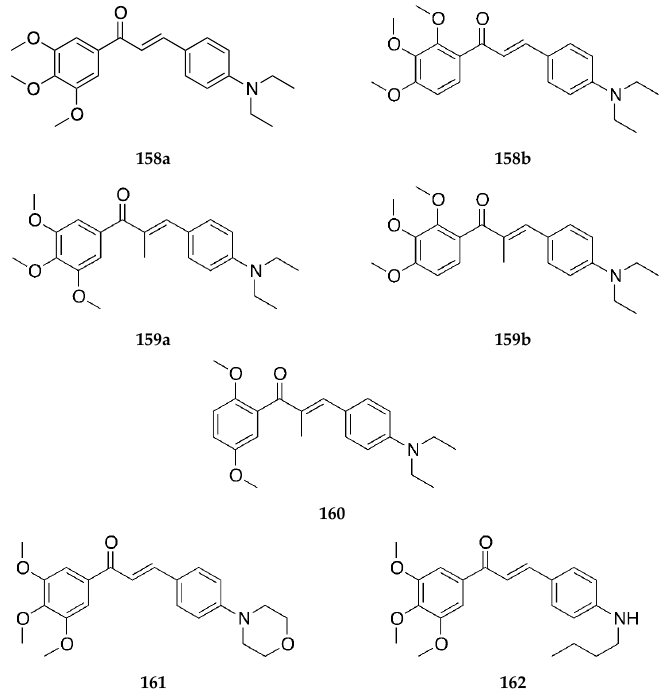
Figure 57. Chemical structure of other alkylated 4′-aminochalcone derivatives with methoxy substitutions on ring A. All compounds 144a , 144c , 143 , and 146 – 162 (Figures 55–57) were tested for their antimitotic activity via an in vitro assay system using HeLa cells. The cell cycle for this asynchronous line is 24 h, and mitosis requires 1 h. Colchicine was used as the reference drug, which stops mitosis at a concentration of 0.05 µg/mL. The activity for these chalcones was reported as the equivalent dose (ED), i.e., the concentration of the test compound with activity equal to 0.05 µg/mL of colchicine. The ED values are shown in Table 25. They also determined the irreversibility of the activity for some compounds by treating HeLa cells with the test compounds for 1 h, by washing them, and by subsequently checking the percentage of cells after 24 h, the results for which can be seen in the paper.